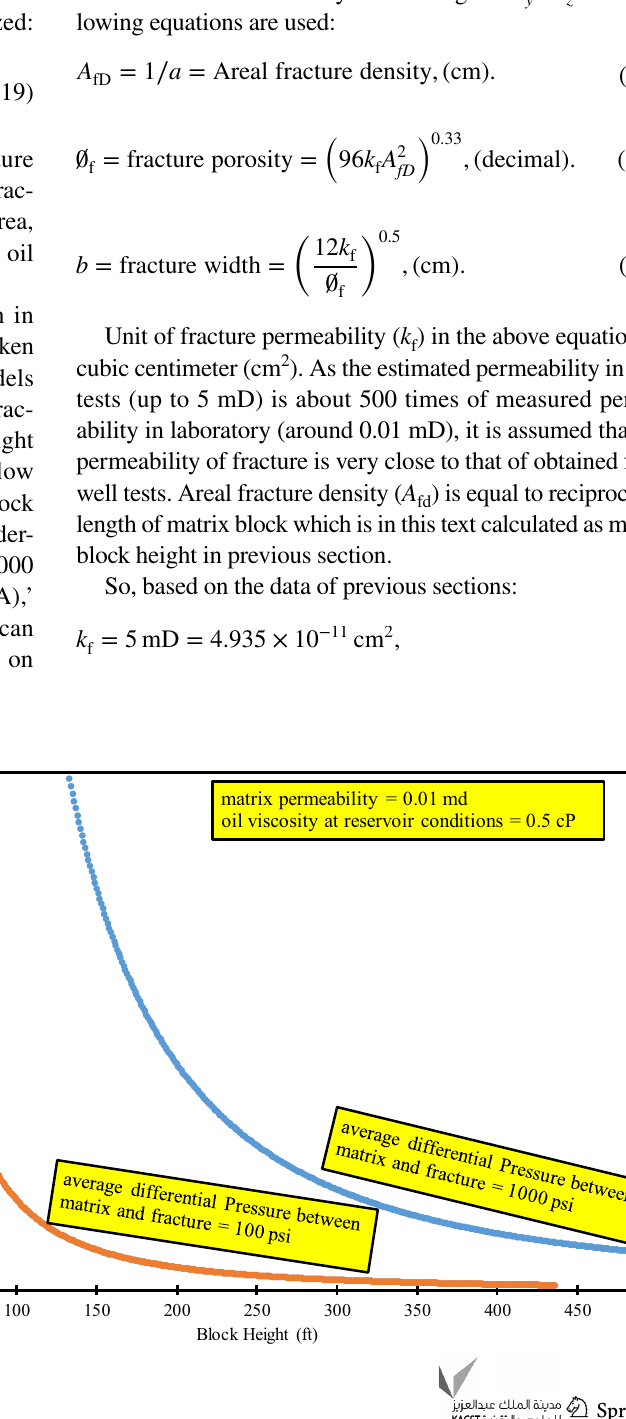
Block Height (ft)